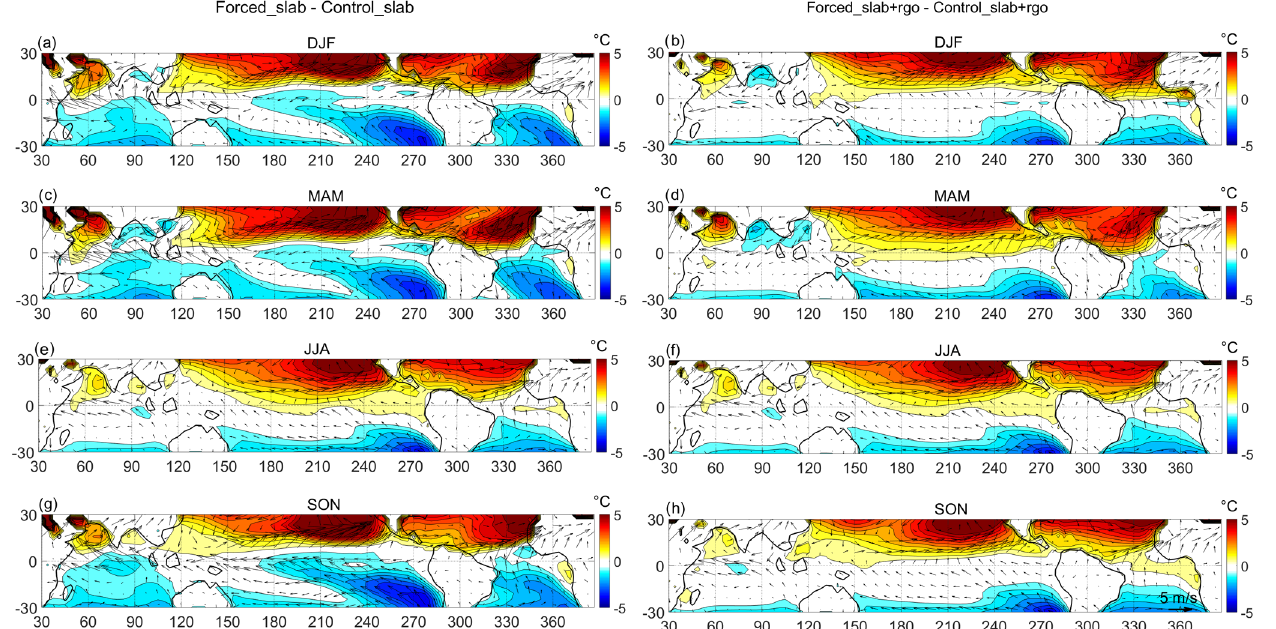
Figure 8. Seasonal SST and near-surface wind anomalies with respect to the control for Forced_slab (a, c, e, g) and Forced_slab + rgo (b, d, f, h) . (a, b) December–February; (c, d) March–May; (e, f) June–August; (g, h) September–November. Contour interval 0.5 ◦